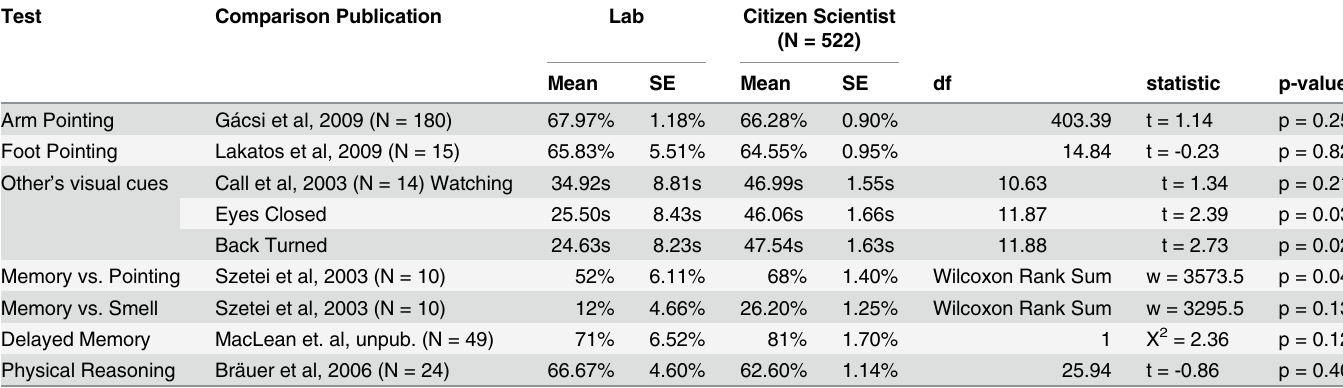
Table 3. Means, Standard Error, degrees of freedom, test statistic and p-value from the quantitative comparisons between laboratory data and citi- zen science data collected through Dognition.com. Welch independent t-tests were used for all comparisons except Memory vs. smell and Memory vs. pointing for which a Wilcoxon sign rank test (continuity corrected) was used, and Delayed Memory for which a proportions test was used.